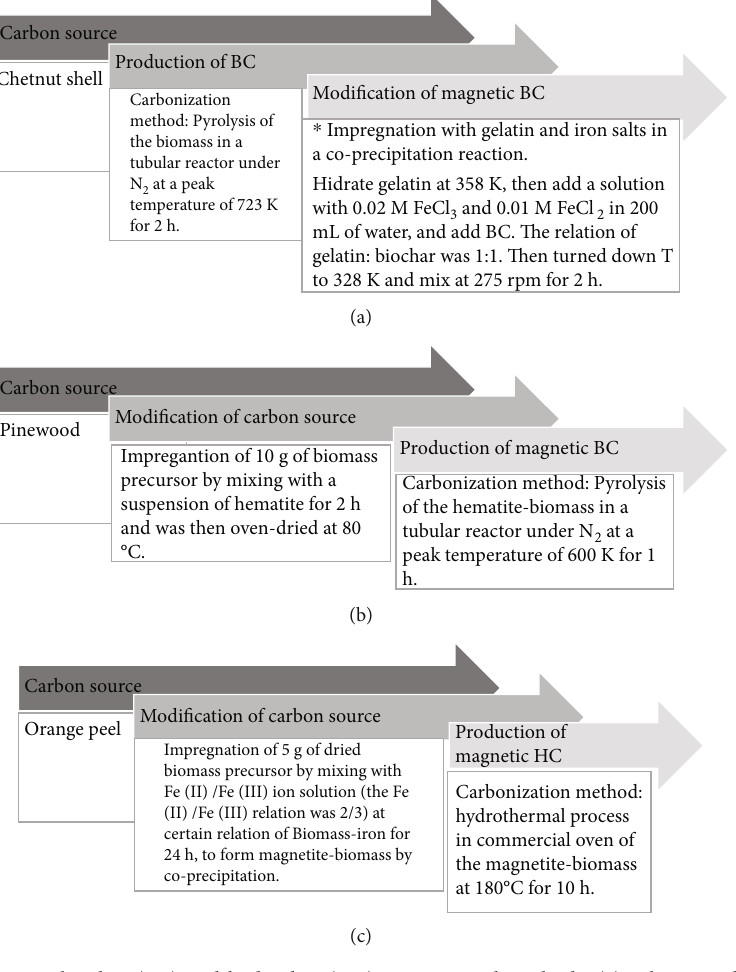
Figure 4: Preparation of magnetic biochar (BC) and hydrochar (HC) using several methods: (a) gelatin modi fi ed-magnetic BC [25], (b) magnetic BC by direct pyrolysis [24], and (c) dendrimer-like magnetic HC by direct hydrothermal carbonization [23]. Additional information for the magnetic iron oxides preparation can be found in Noor et al. [58].